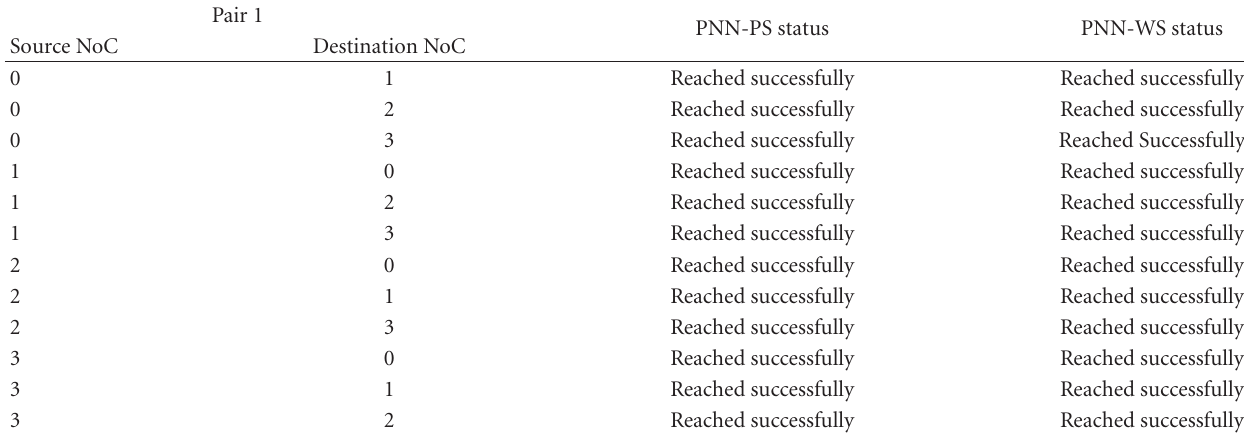
Table 11: The following source destination pair of NoC is used to show 100% e ffi ciency of the NiP (based on PNN, used as IoC). All source destination pair delivered the information to the respective NoC. The following data does not reflect the parallel communication among the NoCs using packet and wormhole switching